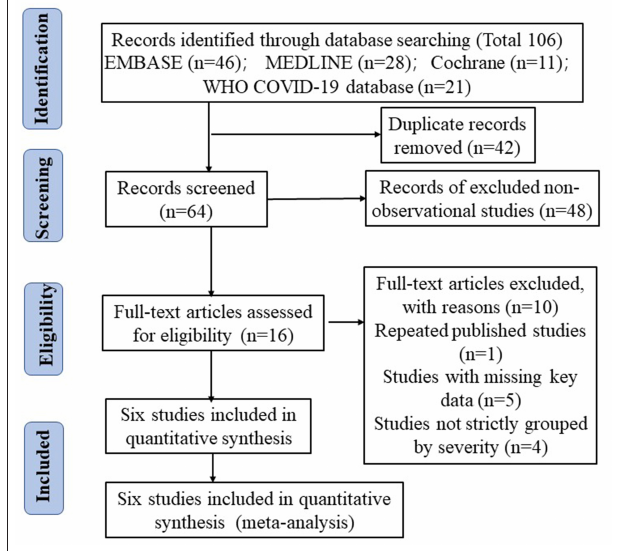
FIGURE 1 | The literature selection process based on the PRISMA flow